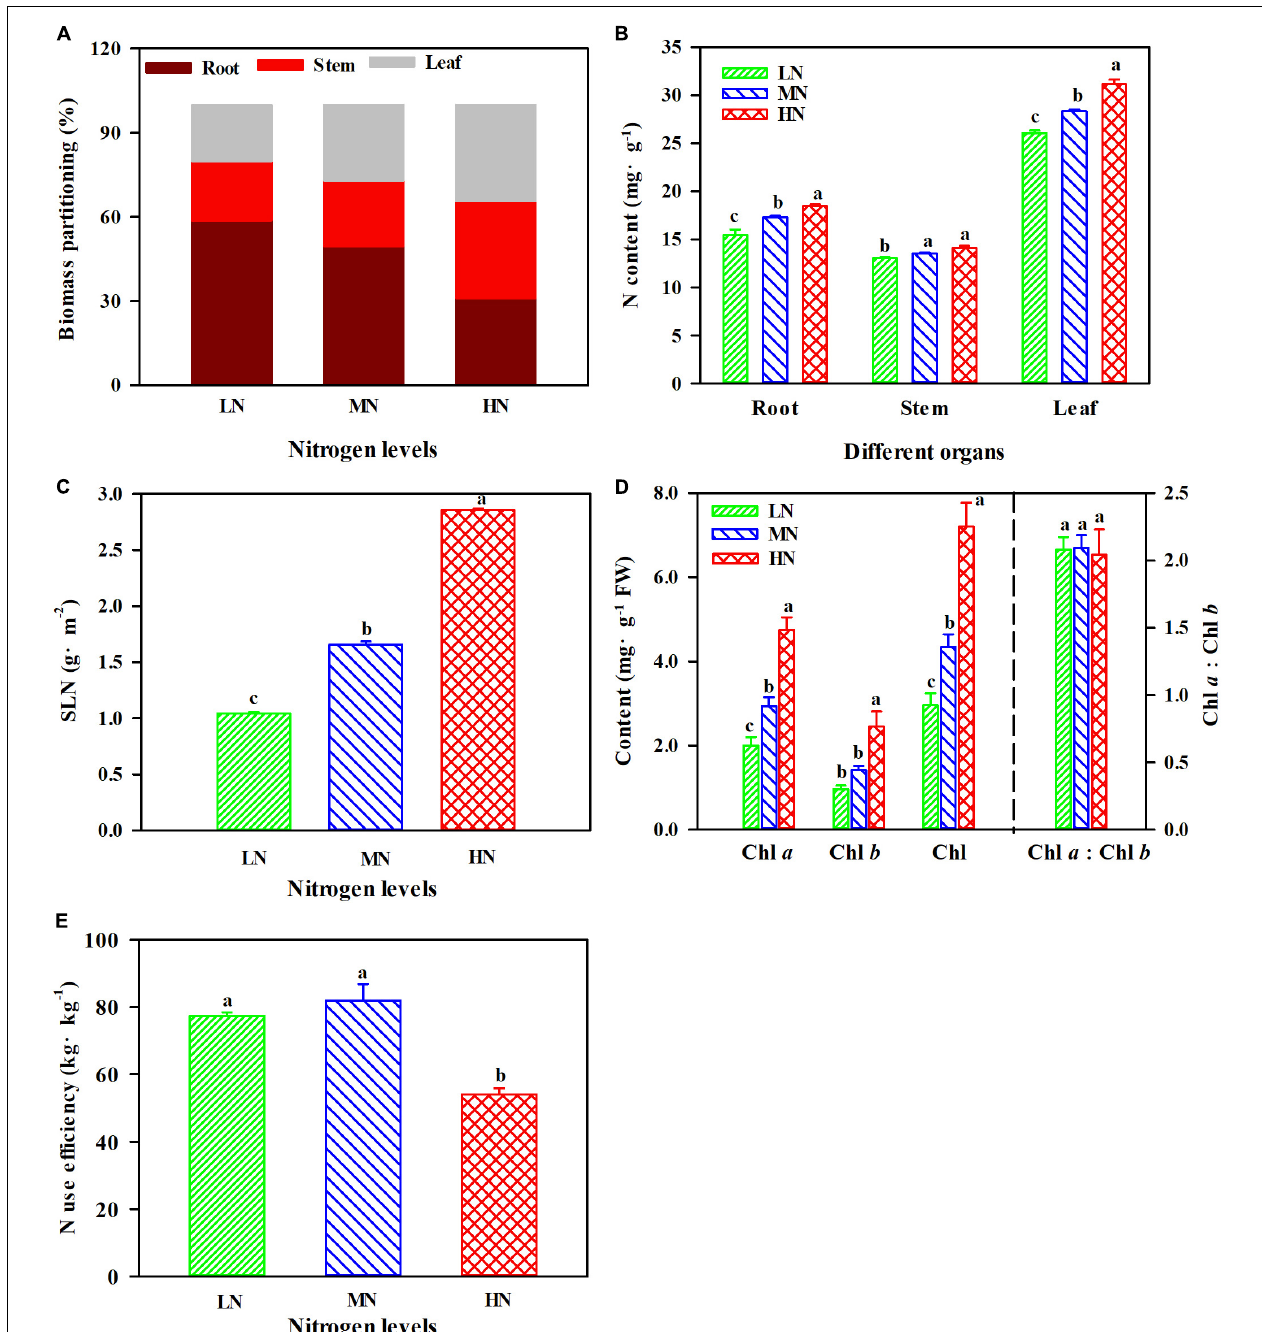
FIGURE 1 | The effect of nitrogen (N) regimes on biomass partitioning (A) , N content (B) , specific leaf N (SLN) (C) , chlorophyll content (D) , and N use efficiency (E) in Panax notoginseng . Values for each point were mean ± SD ( n = 5). Different letters indicate significant differences among treatments (ANOVA; p <